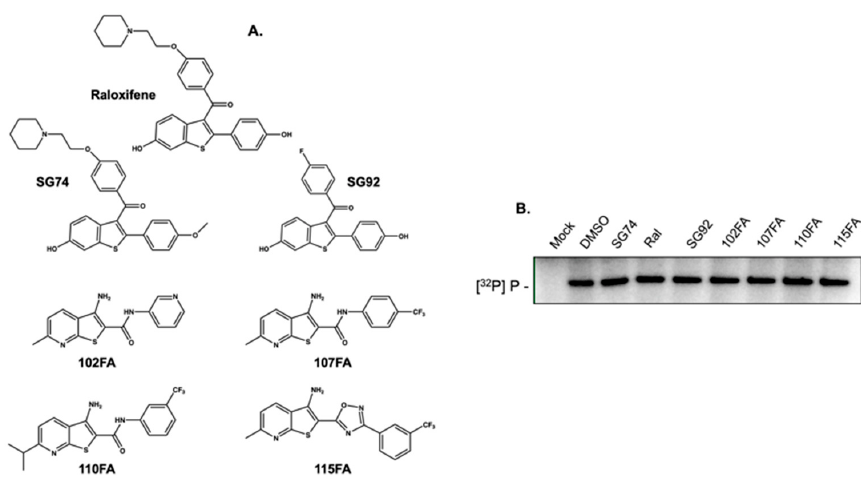
Figure 2. Structurally diverse ligands that identify the HBV ε priming loop fail to inhibit protein priming. ( A ) Structures of the SERM Raloxifene, derivatives SG74 and SG92 and HIV-1 TAR-binding analogs 102FA, 107FA, 110FA, and 115FA. ( B ) ε -dependent initiation of HBV minus-strand DNA synthesis in the presence of the analogs of ( A ). All analogs were tested at a final concentration of 100 µ M.